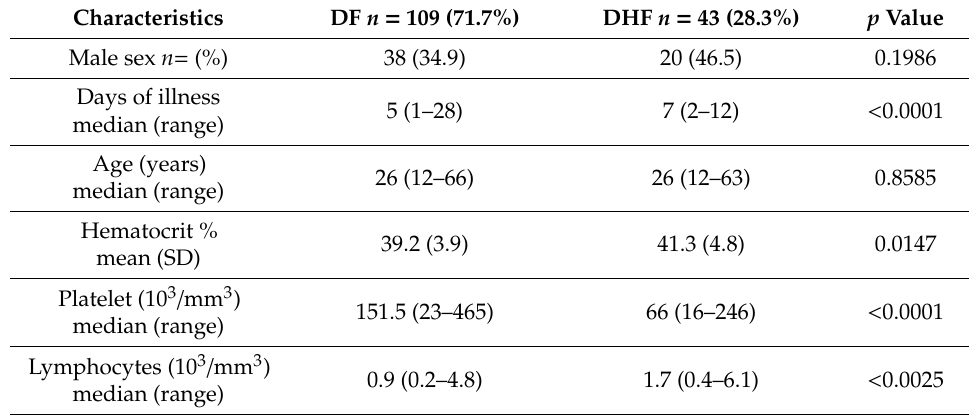
Table 1. Demographic and clinical characteristics of the study patients with dengue fever (DF) and dengue hemorrhagic fever